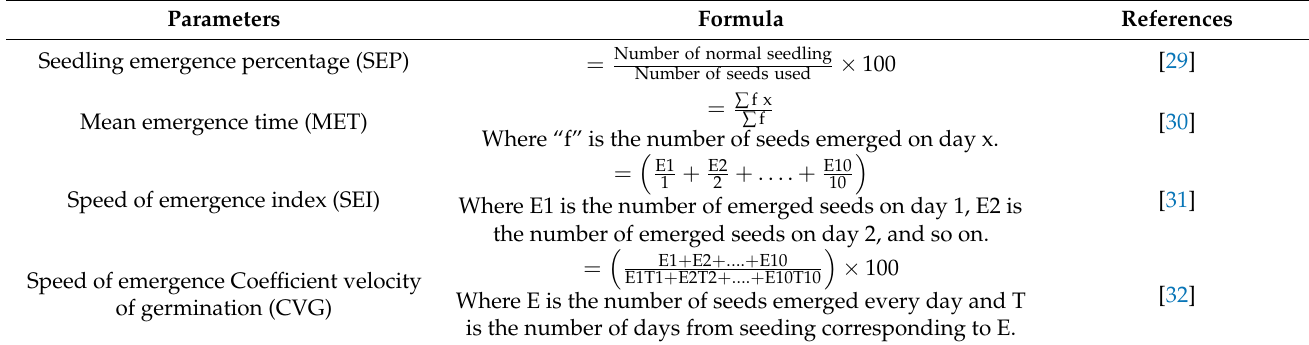
Table 3. Formulas for the calculation of seedling emergence related